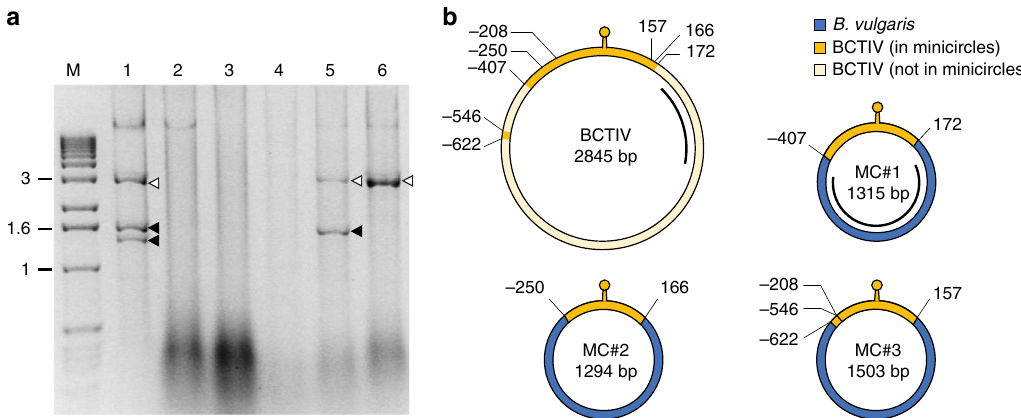
Fig. 1 Identi fi cation of chimeric minicircles in fi eld-grown sugar beet plants. a DNA fragments obtained after RCA and Eco RI digestion of DNA samples from different plants (lanes 1 – 6) collected from a fi eld in Iran. The putative full-length BCTIV genome and smaller molecules are indicated by white and black arrows, respectively. Lane M, molecular markers with the size (kb) indicated on the left. Source data are provided as Supplementary Data 5. b Schematic representation of BCTIV and the three minicircles obtained from some of the BCTIV-infected fi eld samples shown in a ; MC#1 originates from plant 5, MC#2 and #3 from plant 1. The BCTIV and the minicircle genomes are represented in circular form; yellow and blue represent the BCTIV and the B. vulgaris genome-derived elements, respectively. The recombination coordinates on the BCTIV genome and the minicircles are indicated in nucleotides in relation to the conventional start of the BCTIV genome located at the stem-loop region (marked as a yellow lollipop). The locations of the MC#1- and BCTIV-speci fi c probes used for subsequent southern blot analysis are represented by black lines. The complete minicircle sequences are reported in Supplementary Data